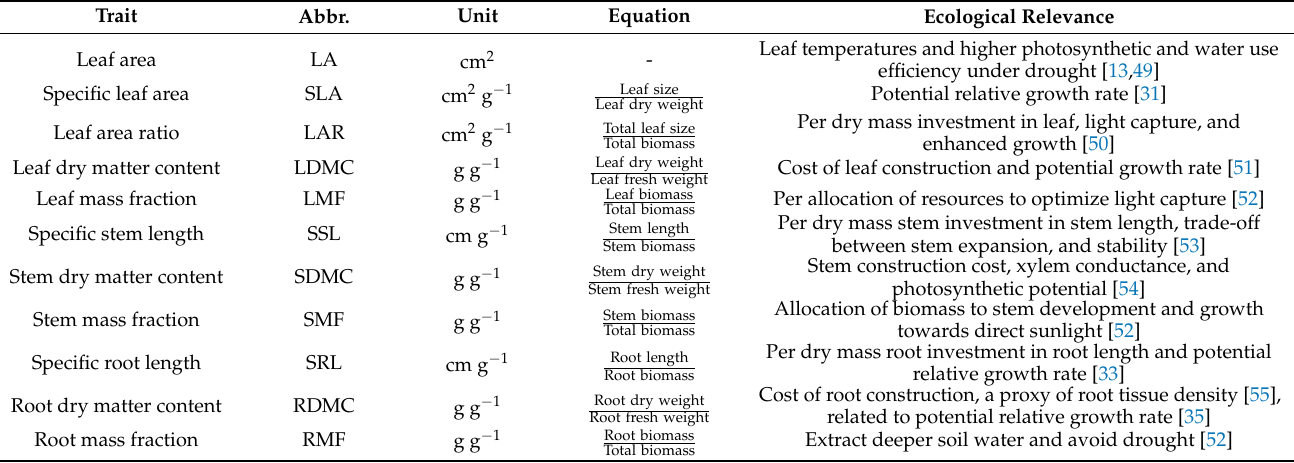
Table 1. Trait overview with abbreviations, units, equations, and ecological relevance. Abbr. Unit Equation Ecological